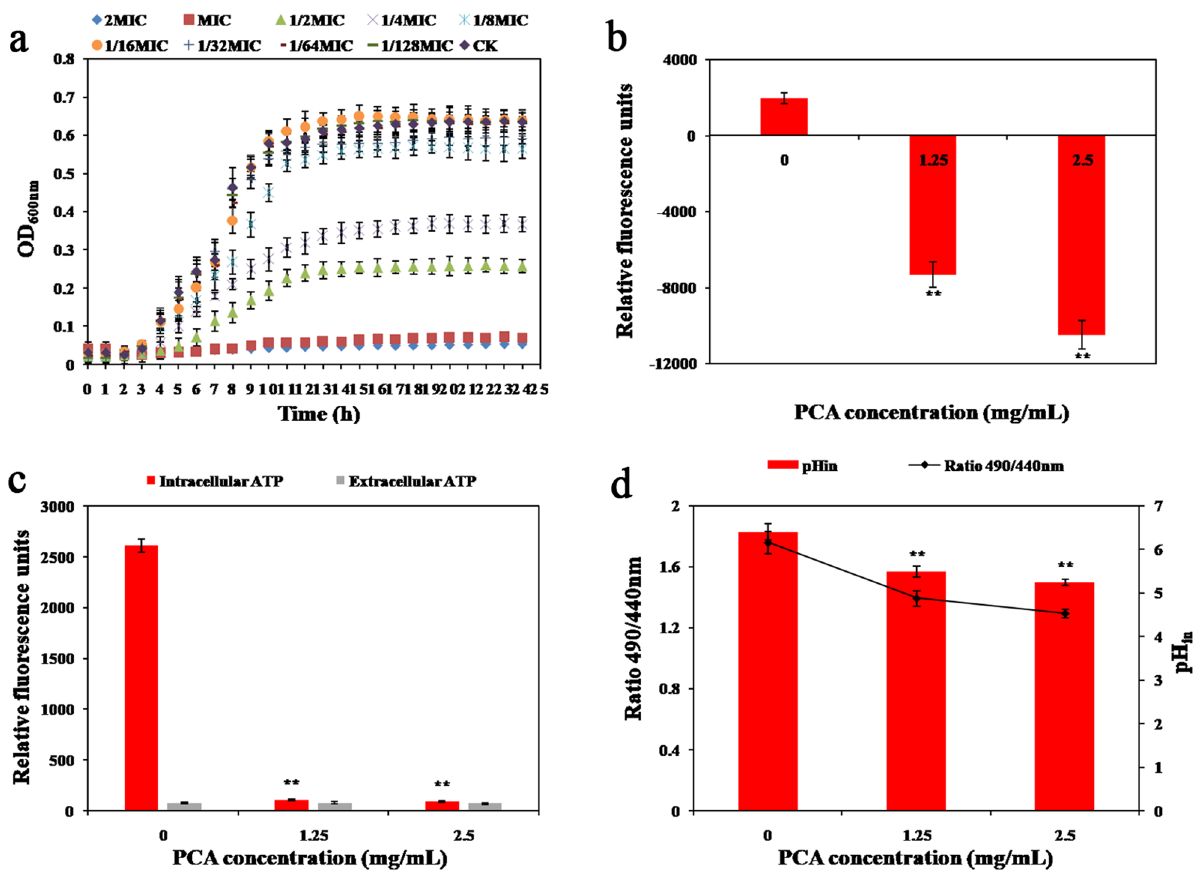
Figure 1. ( a ) The growth curves of M. luteus BNCC 102589 exposed to different concentrations of PCA. ( b ) The effects of PCA on the membrane potential of M. luteus BNCC 102589. ( c ) The effects of PCA on intracellular ATP levels of M. luteus BNCC 102589. ( d ) The effects of PCA on the pH in of M. luteus BNCC